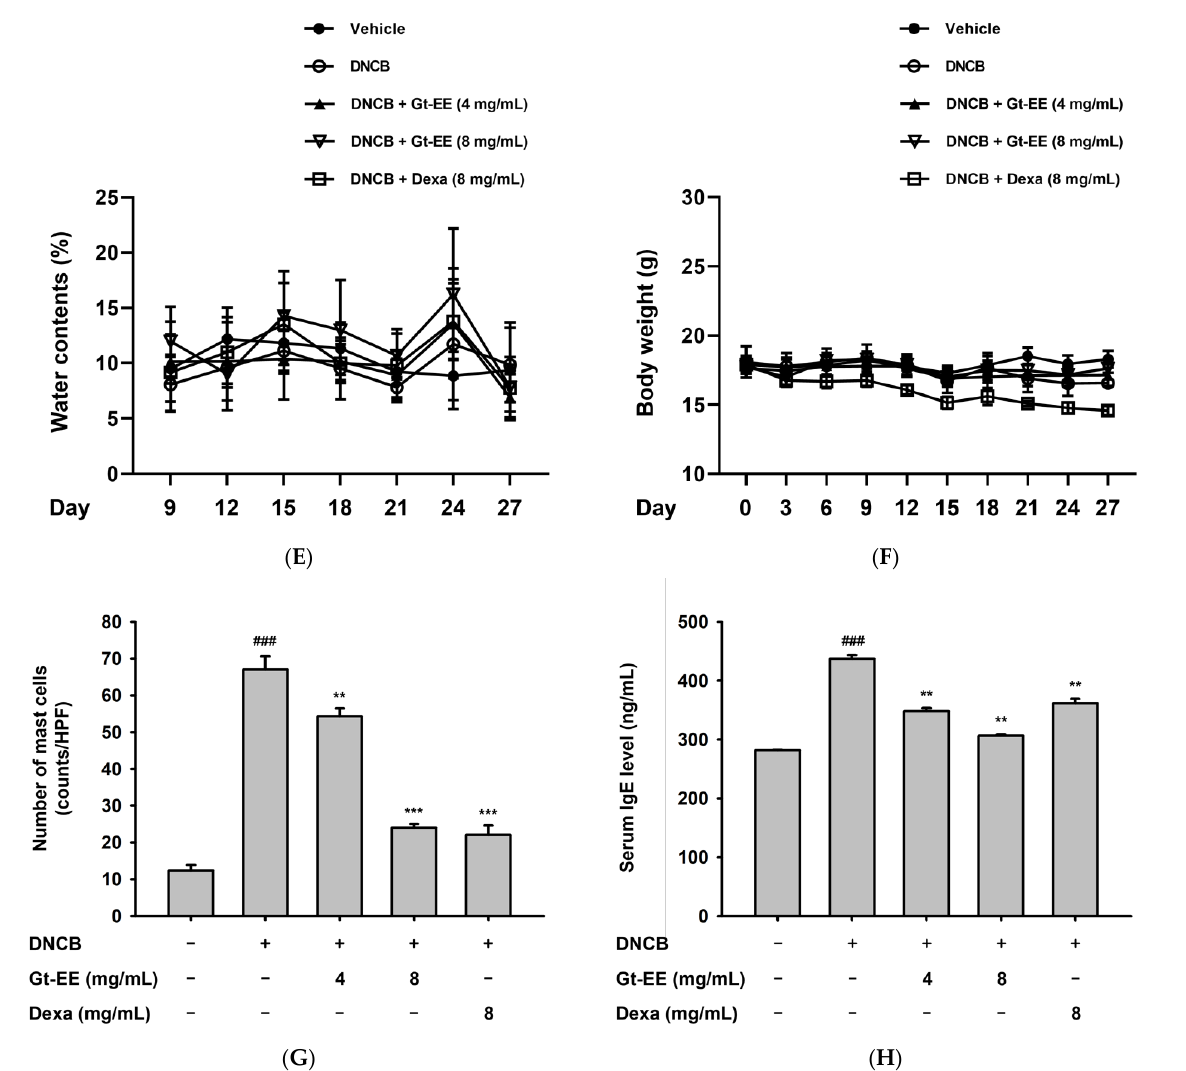
Figure 4. Effects of Gt-EE on DNCB-induced AD-like lesions. ( A ) scheme for induction of AD using DNCB in the ears of BALB/c mice. The ears were sensitized by 1% DNCB on day 9, and then 0.5% DNCB was applied to the ears every 3 days after sensitization. Gt-EE and dexamethasone were applied to the ears every day. Dexamethasone was used as the positive control; ( B ) photographs of BALB/c ears on which AD was induced and H&E- or toluidine blue O – stained ear tissues. Histo- pathological variations and alterations in mast cell counts due to DNCB treatment were investigated using H&E and toluidine blue O staining, respectively. The red arrows indicate toluidine blue O – stained mast cells. ( C ) The dermatitis score was measured every 3 days using itching, erythema, and dryness (No change — 0, slight change — 2, moderate change — 4, severe change — 8). ( D ) Alterations in ear thickness were measured using dial thickness gauges (PEACOCK, Japan). ( E ) Water content was evaluated using an SK-IV digital moisture monitor for skin (Pandawill, China) every 3 days. ( F ) The body weight of the mice was measured to check the toxicity of Gt-EE. ( G ) The number of mast cells in ear tissue was counted under a microscope at 400× magnification. ( H ) The serum IgE level was measured using ELISA. After euthanasia, blood was extracted directly from the heart, and the serum was separated by centrifugation. ( C – H ) The results are expressed as mean ± standard deviation. ### p < 0.001 compared with the normal group, and ** p < 0.01, *** p < 0.001 compared with the control group.